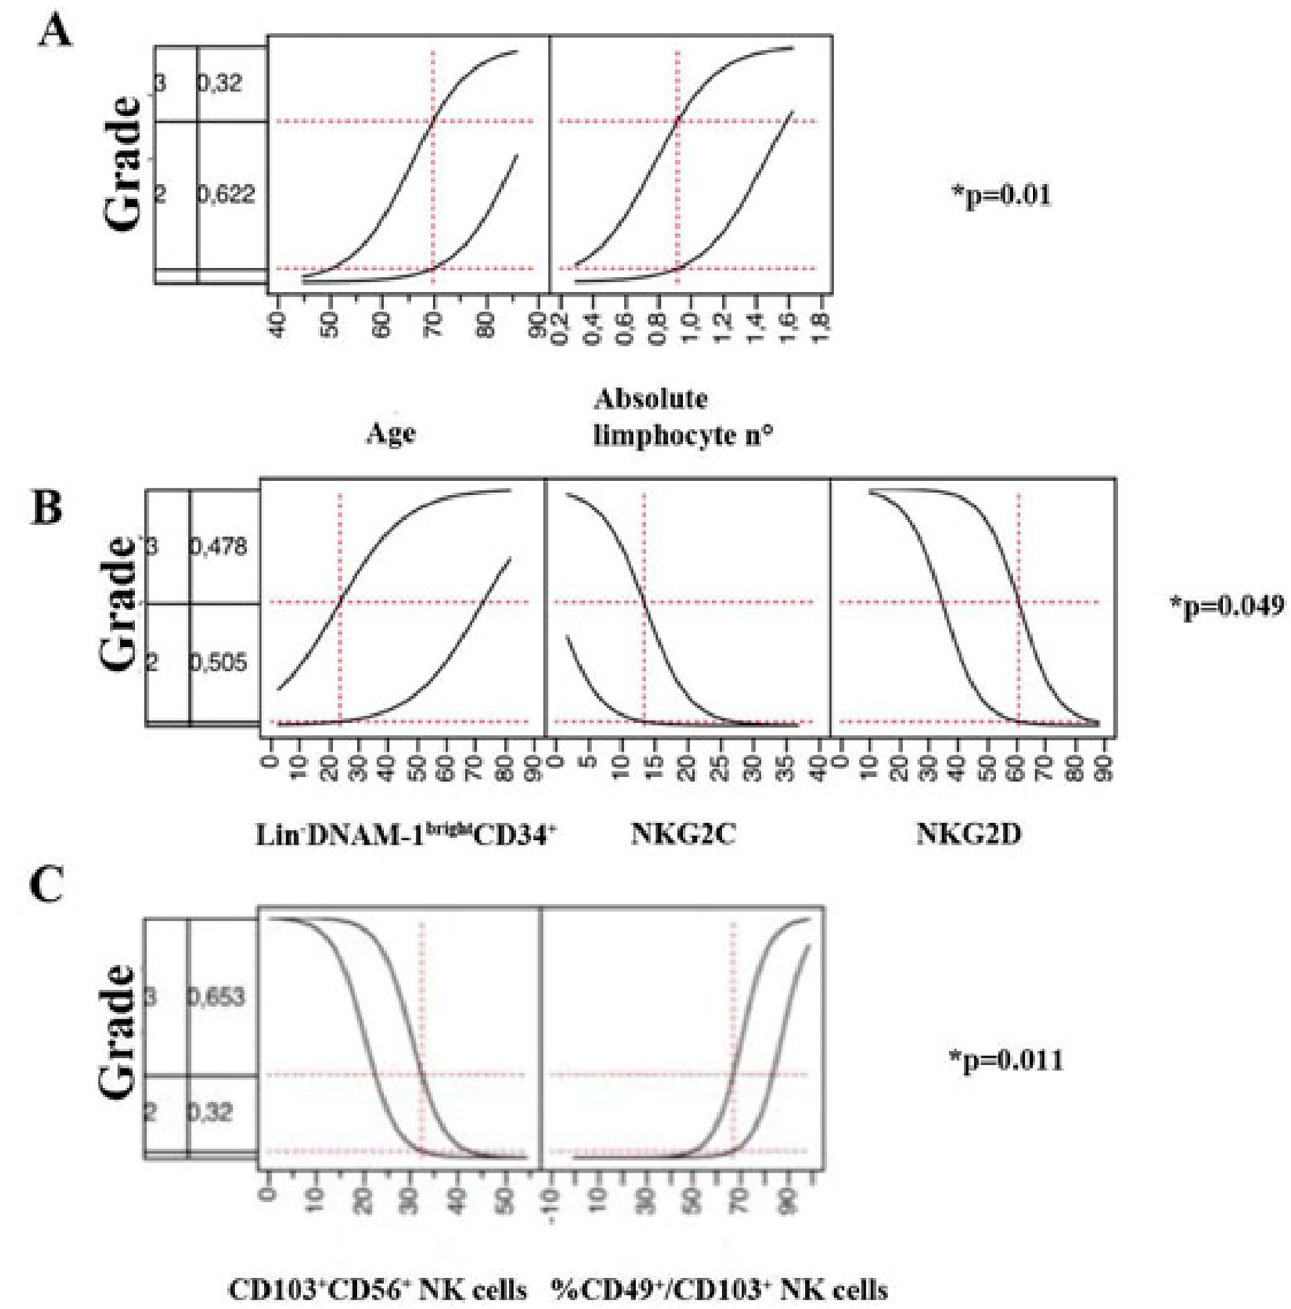
Fig 5. Ordinal logistic fit of variables with subsequent clinical trajectory according to modified WHO classification. Panel A: Logistic profiler for the disease course for age and lymphocyte n˚ at admission according to subsequent disease trajectory. Logistic fit of the model is indicated. The vertical dotted line for given X variables shows a representative current value (red number). Horizontal dotted lines show the current predicted value for the displayed values of the X variables. Panel B: Logistic profiler for disease course according to the proportion of CD34+DNAM bright CXCR4+ cells, the proportion of NKG2D+ and of NKG2C+ NK cells. Logistic fit of the model is indicated. The vertical dotted line for given X variables shows a representative current value (red number). Horizontal dotted lines show the current predicted value for the displayed values of the X variables. Panel C: Logistic profiler for disease course according to the proportion of CD103+ NK cells and of CD49+CD103+ NK cells. Logistic fit of the model is indicated. The vertical dotted line for given X variables shows a representative current value (red number). Horizontal dotted lines show the current predicted value for the displayed values of the X variables.